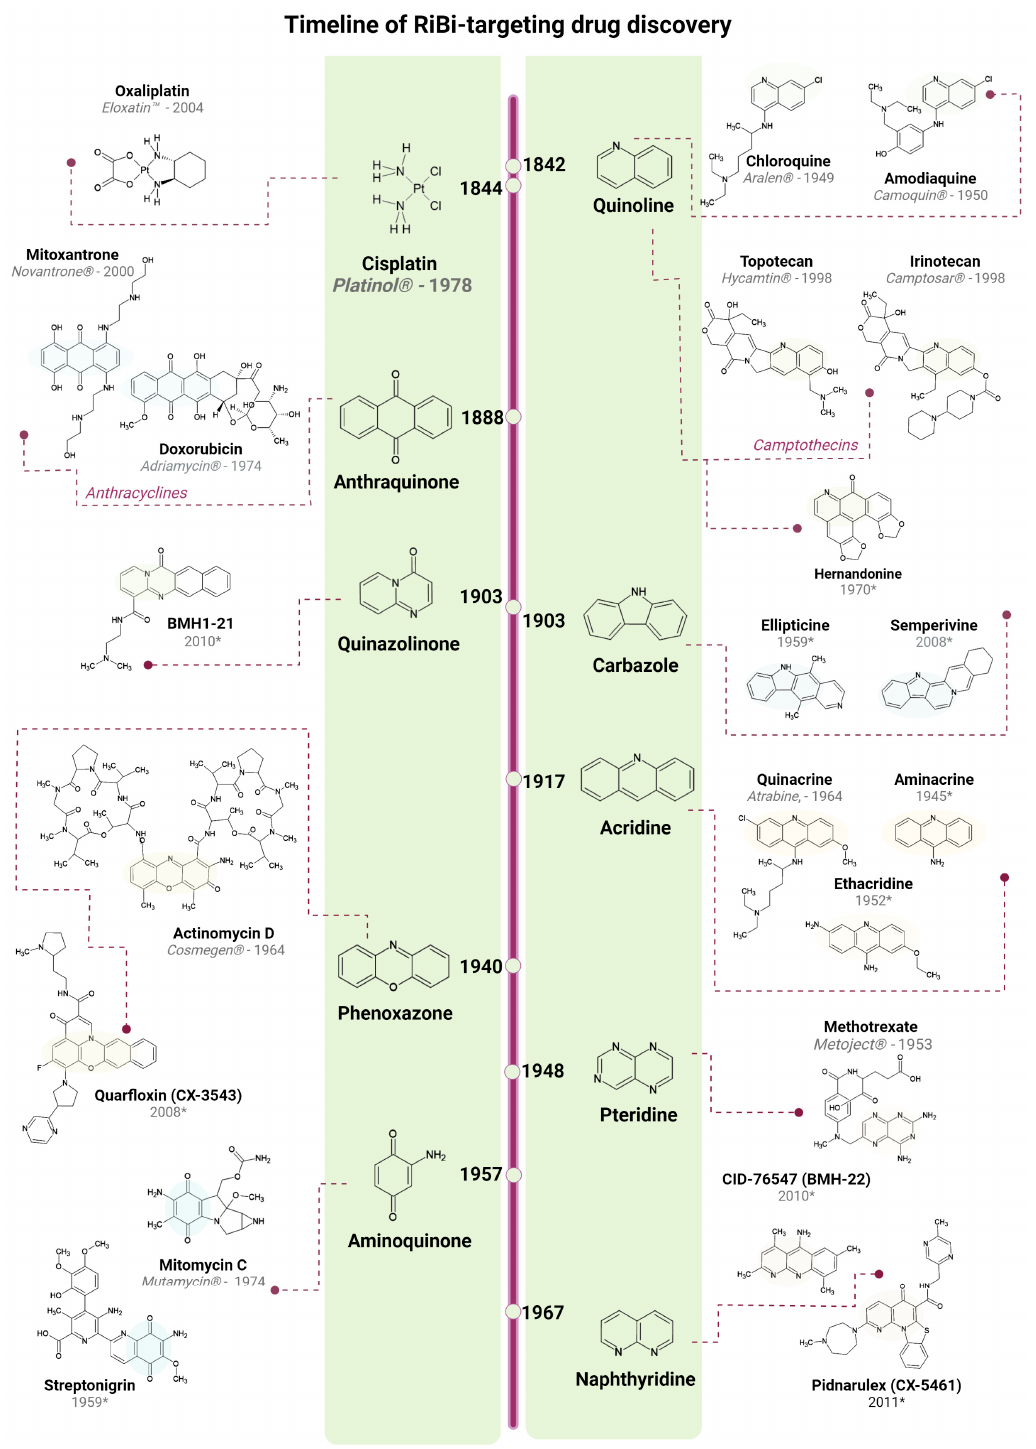
Figure 2. A schematic timeline of the most common substructures found in RiBi inhibitory cancer drugs. Drugs known to interact with the RiBi machinery are listed along with their name, trade name, and clinical approval year. Investigational drugs are shown with their name and the year they first appeared in the literature in italics with an asterisk. The drugs are grouped based on their substructure, shown on the green-colored box, with the initial discovery or synthesis year. The figure was created with Biorender.com under academic